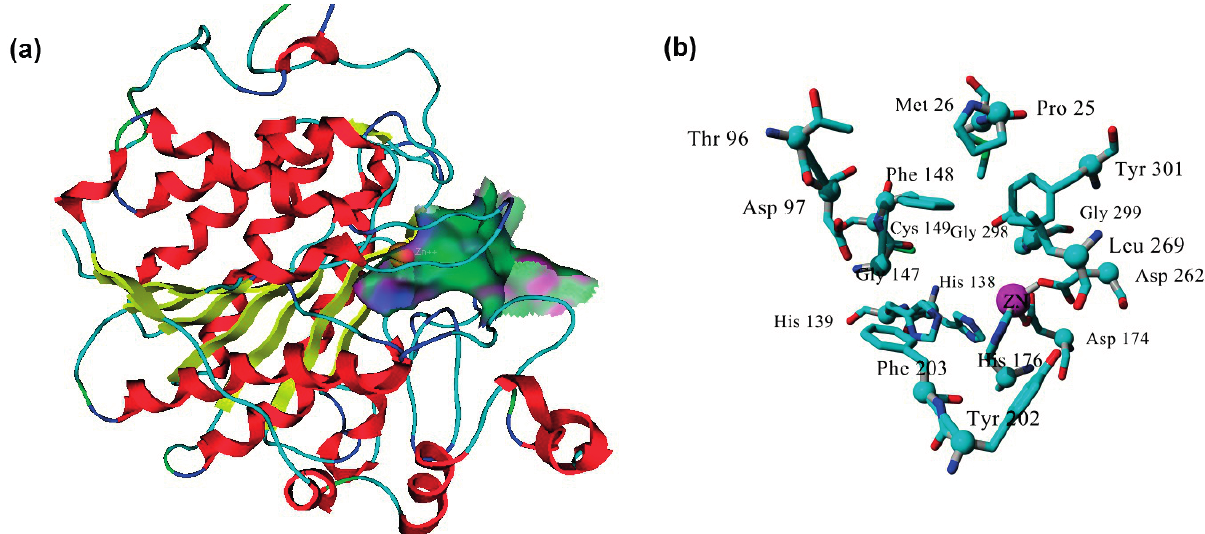
Figure 5. Plasmodium falciparum histone deacetylase1 ( Pf HDAC1) active site. ( a ) Gaussian contour of the Pf HDAC1 model active site (pink represents hydrogen bonding; green represents hydrophobic contact residues; blue represents mild polar amino acids); and ( b ) key residues of the model active